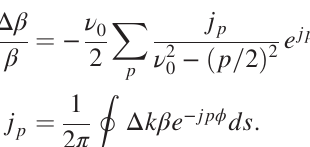
FIG. 4. Stop band harmonics vs strength scaling factor of quadrupole errors, randomly distributed to 36 quadrupoles. The scaling factor 1 corresponds to 0.1% rms error to quadrupoles with 3 σ cutoff.